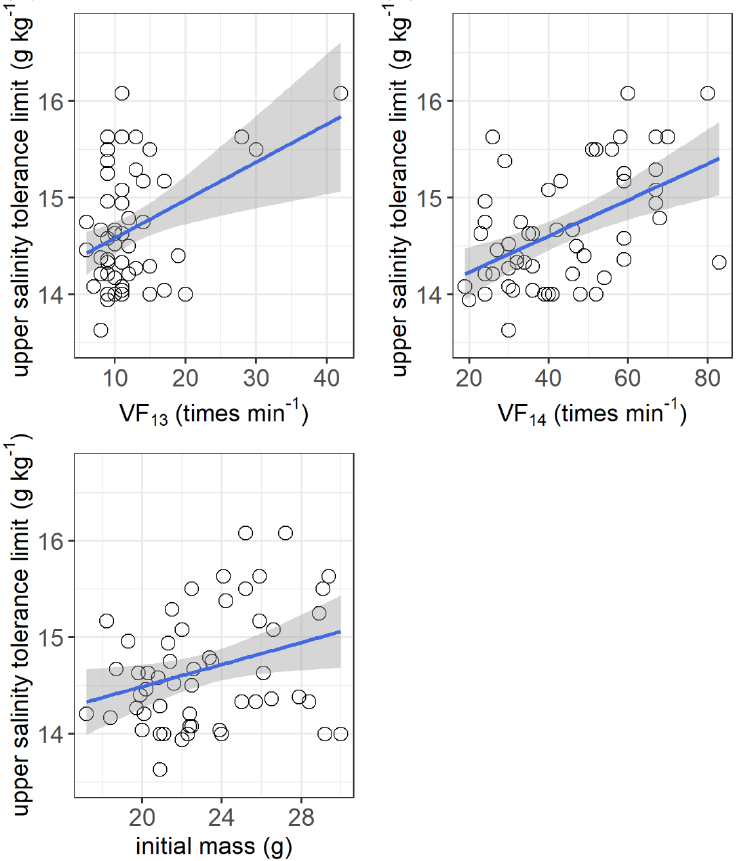
Figure 5. Correlations between upper salinity tolerance limit (g kg − 1 ) and ventilation frequency at salinities of 13 g kg − 1 (VF 13 , times min − 1 ) and 14 g kg − 1 (VF 14 , times min − 1 ) and initial body mass (g) of grass carp. VF 13 : r 2 = 0.155, p = 0.0032; VF 14 : r 2 = 0.253, p = 0.003; initial mass: r 2 = 0.092, p = 0.026. The data are shown by the circles and the regressions are shown by the blue line.